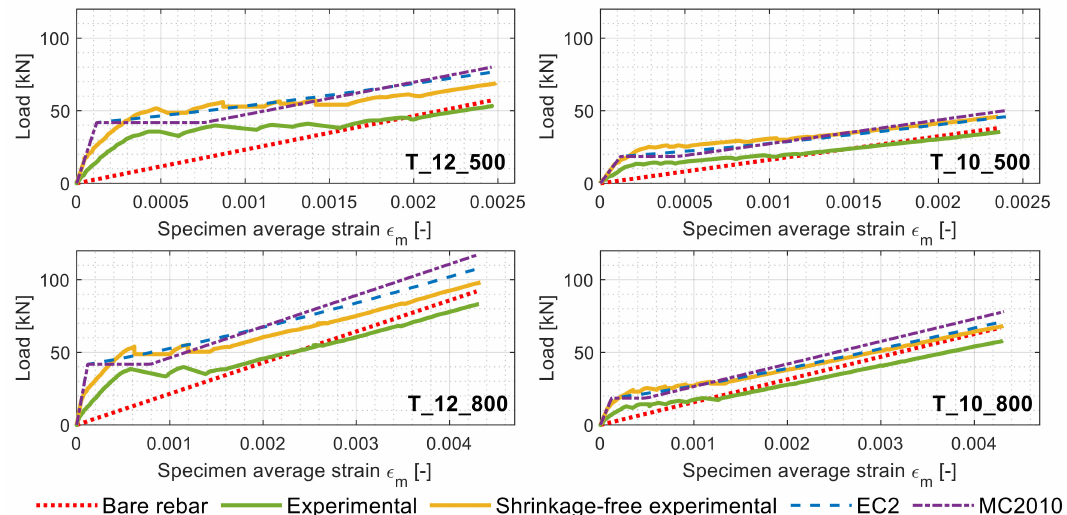
Figure 5. Load–specimen average strain diagrams of the study case members before and after shrinkage elimination along with the EC2 and MC2010